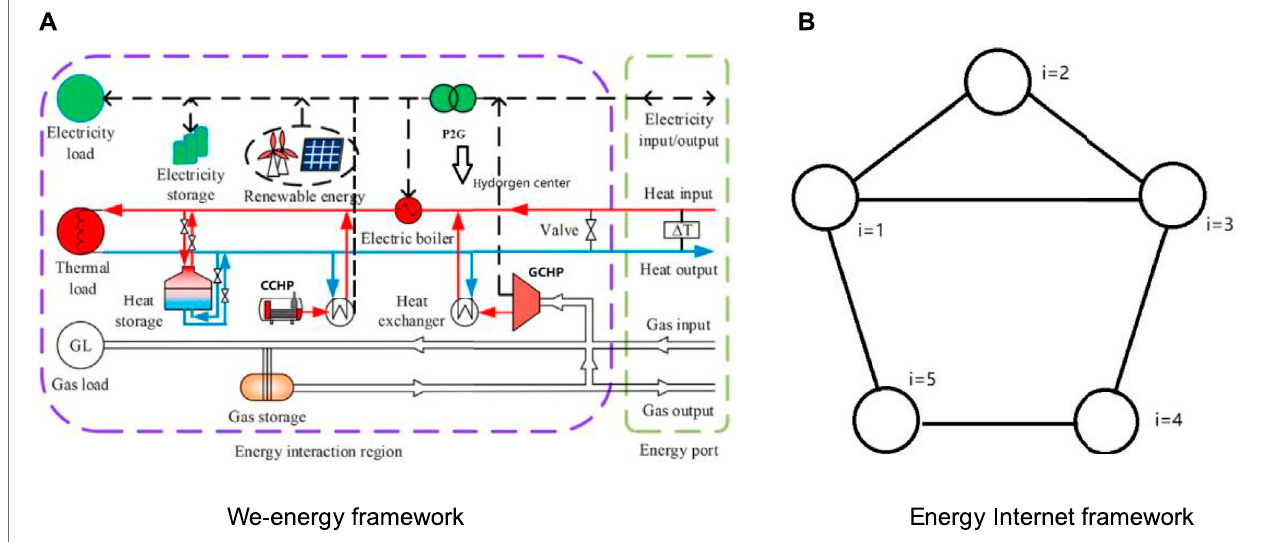
FIGURE 1 | (A) We-energy framework. (B) Energy Internet